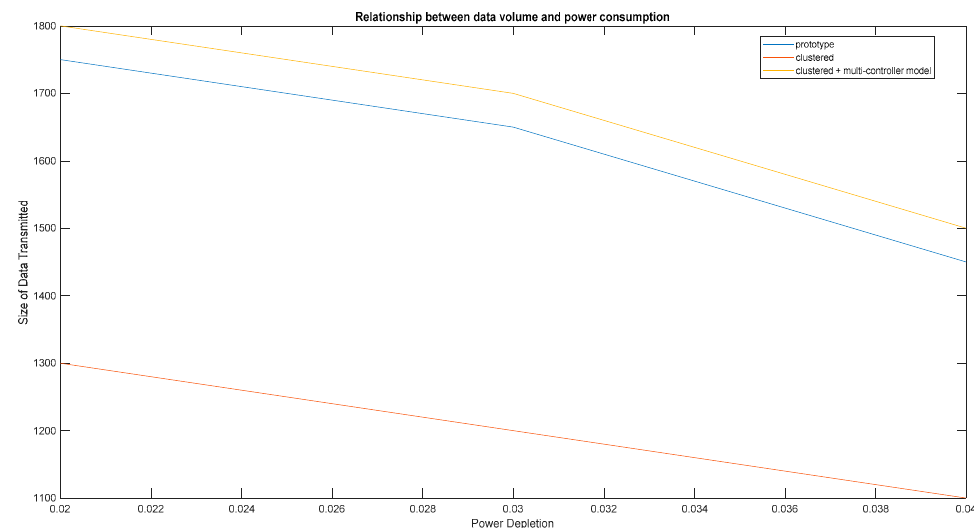
Figure 19. Relationship between data volume and power